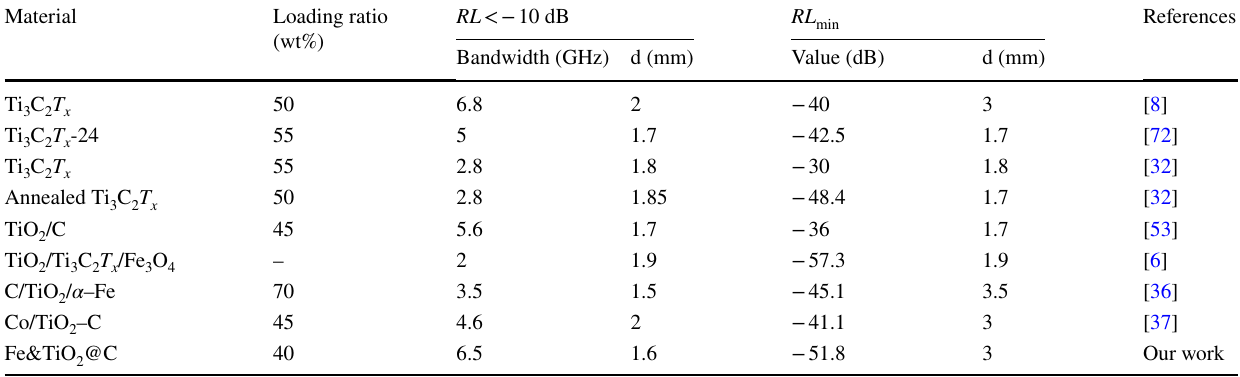
Table 2 EMW absorption performance of MXene‑based materials Material Loading ratio